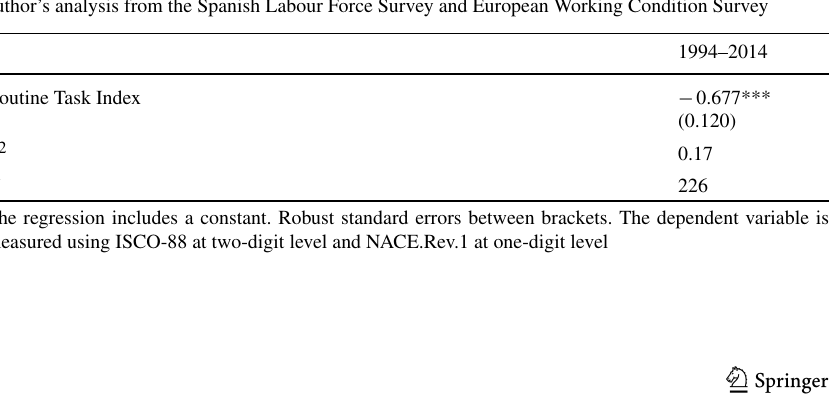
Table 7 OLS regression of changes in employment share and the initial level of routine intensity. Sources : author’s analysis from the Spanish Labour Force Survey and European Working Condition